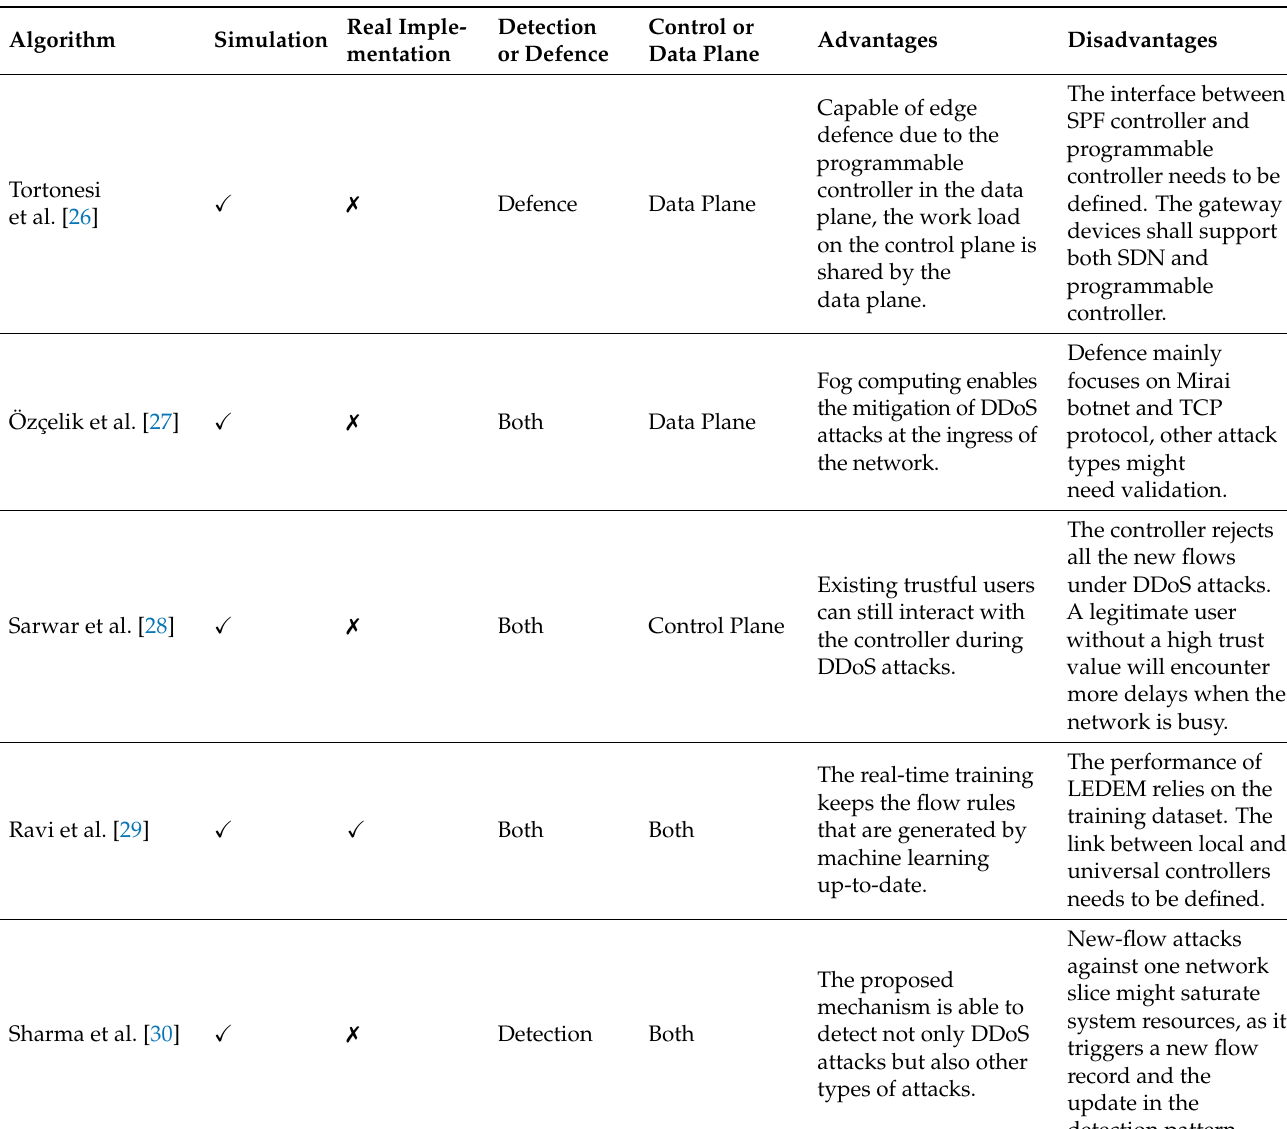
Table 2. Countermeasures in SDN-based IoT